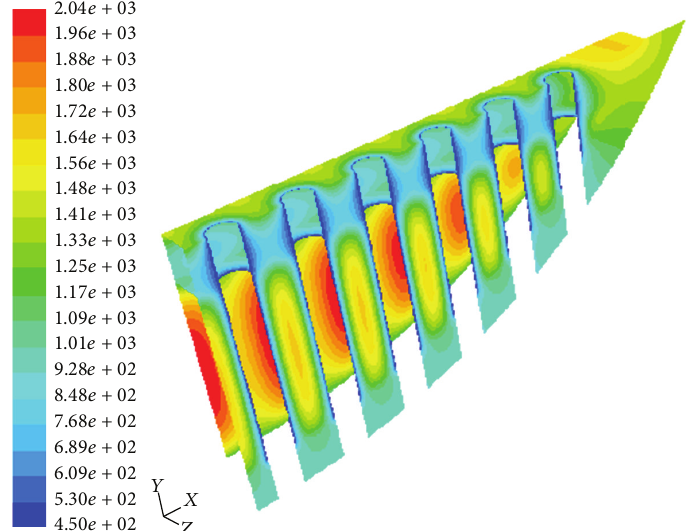
Figure 19: Temperature contour of the debris pool and vessel wall (steady-state